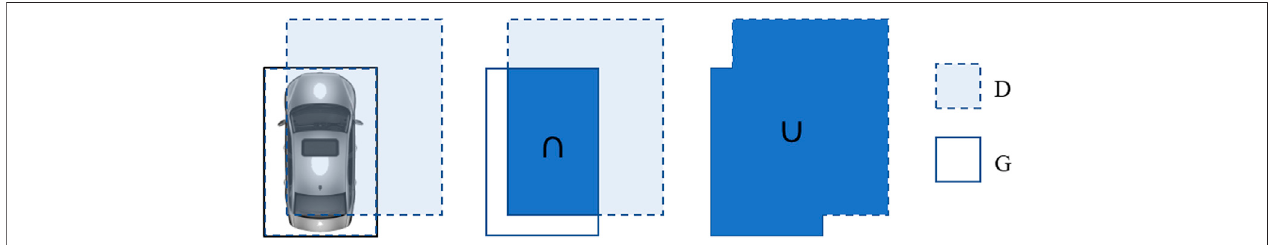
FIGURE 4 | IoU indicator for quantifying the performance of perception